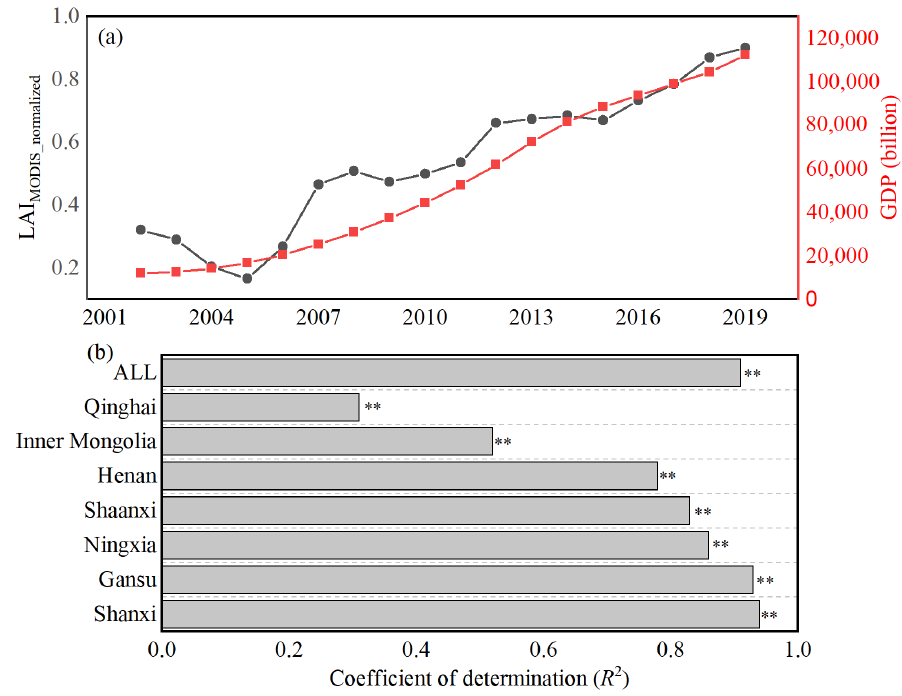
Figure 9. Relationship between LAI MODIS_normalized and gross domestic product (GDP) since 2000 for ( a ) the Loess Plateau and ( b ) different provinces. ** represents P < 0.01.